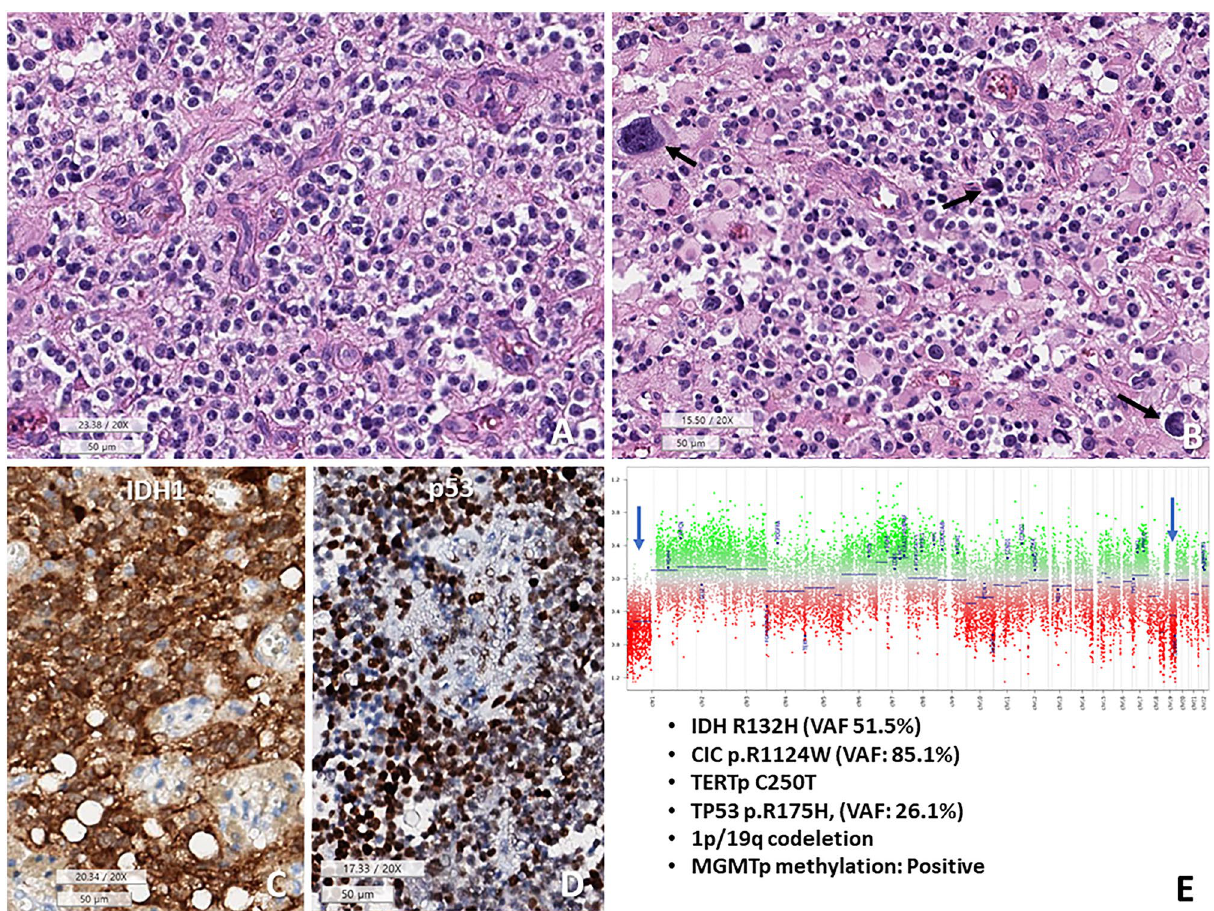
Figure 3. The second case of TP53 mutant oligodendroglioma, CNS WHO grade 3. ( A ) Tumor shows fried egg-appearing monotonous round cells with microvascular proliferation. ( B ) Some tumor cells have pleomorphic and hyperchromic nuclei (arrows) and abundant eosinophilic cytoplasm. This photo is a little bit out of focus because of nearby calcifications. ( C , D ) These tumor cells are positive for IDH1 (H09) and P53. ( E ) Copy number variation plots obtained from methylation profiles represent 1p/19q codeletion (one copy deletion). In addition, CIC (p.R1124W, VAF: 85.1%), TERT promoter (C250T), TP53 (p.R175H, VAF: 26.1%) mutations and MGMT promoter methylation are present ( A , B H&E, C IDH1 IHC, D p53 IHC, E CNV plot, under bar sizes A – D 50 tion of inhibitory histone markers induced by increased 2-HG levels in IDH mutant gliomas 18 . We believe that 2-HG may play a pivotal role in histone demethylation. CpG island DNA methylation in the nonpromoter region of IDH mutant cells, that is, DNA methylation of the CCCTC-binding factor (CTCF) binding site, results in loss of the insulated site, intercepts the topographically associated domain (TAD) boundary, and leads to an active enhancer in genes, such as PDGFRA 21 . Dysfunction of tumor‑suppressor genes, TP53 in astrocytoma, CIC and FUBP1 in oligodendro‑ glioma. IDH mutations are an early oncogenic molecular change in IDH-mutant gliomas. Mutation of IDH can cause oncogene (oncometabolite)-induced cellular senescence 22 . Constitutive activation of RB1 , TP53 , and CDKN2A is a well-known growth arrest signaling pathway that produces hypoproliferative senescent cells 23 . Senescent glioma cells adopt a different path to survive. Tumor cells need to block senescence-inducing TSGs, such as TP53, RB1, and CDKN2A/2B , so that can bypass senescence-induced tumor cell apoptosis. These molec- ular mechanisms may induce simultaneous TP53 mutations in A_IDH_mut and CIC and/or FUBP1 mutations in O_IDH_mut to obtain proliferative activity and to avoid cellular senescence. CIC mutations are found in approximately 70% of oligodendrogliomas 24 , and we found them in 75.7% of our O_IDH_mut tumors. CIC is an important tumor suppressor that acts through transcriptional repression of target genes, including the polyoma enhancer activator 3 (PEA3) subfamily of E26 transformation-specific (ETS) transcription factors 24 . CIC is a transcriptional repressor that recruits histone deacetylations. CIC inactivation by mutations or deletion increases the level of histone acetylation, leading to transcription of EGFR/RAS/MAPK pathway components, promoting mitogen-independent tumor growth 24 .